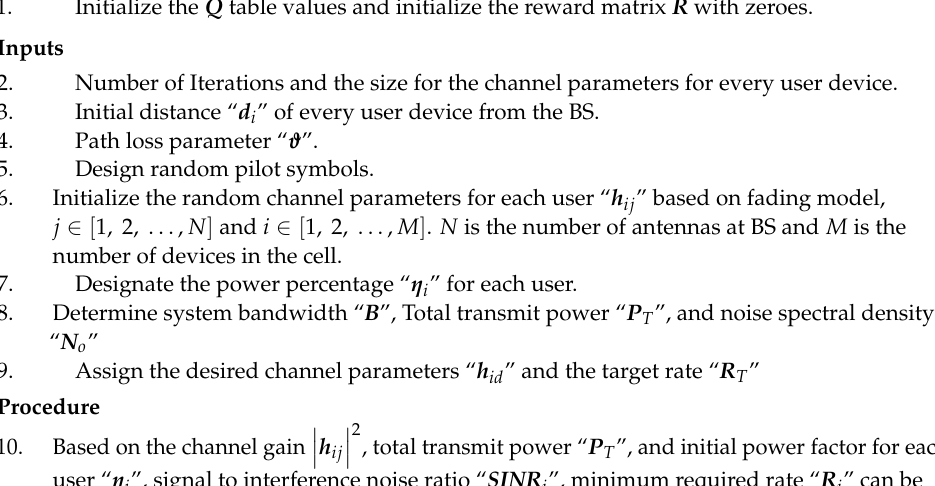
Algorithm 1: Developed Q -learning Channel Prediction